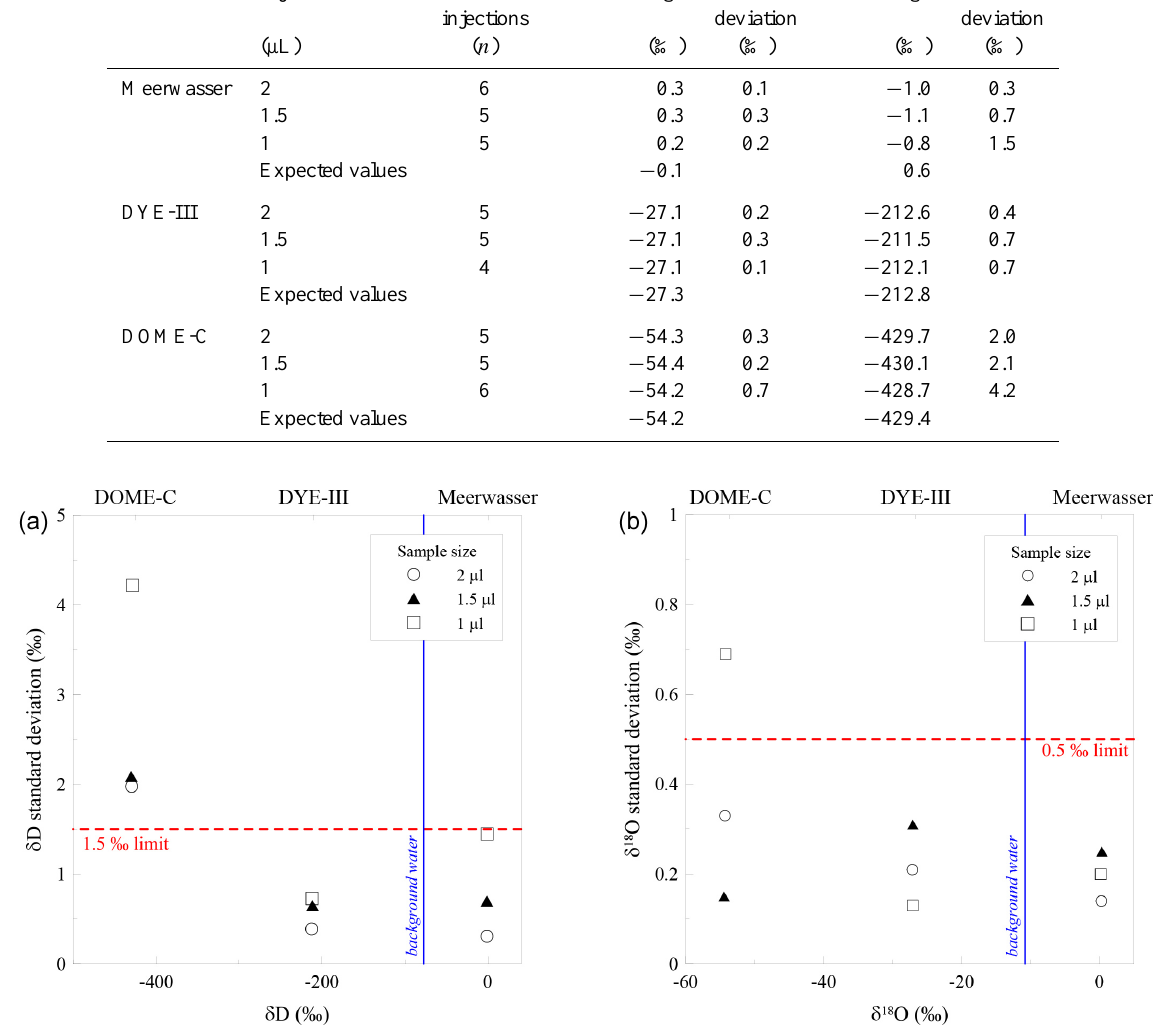
Figure 11. Summary of the reproducibility tests made for different standard waters ranging from 0 to − 450‰ for δD (left panel) and from 0 to − 55‰ for δ 18 O (right